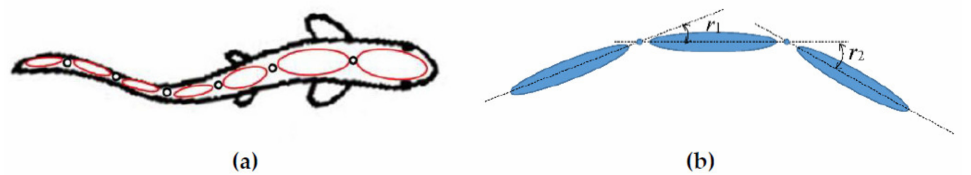
Figure 1. ( a ) Preliminary multi-body model for swimming fish; ( b ) coupled active and passive model in current